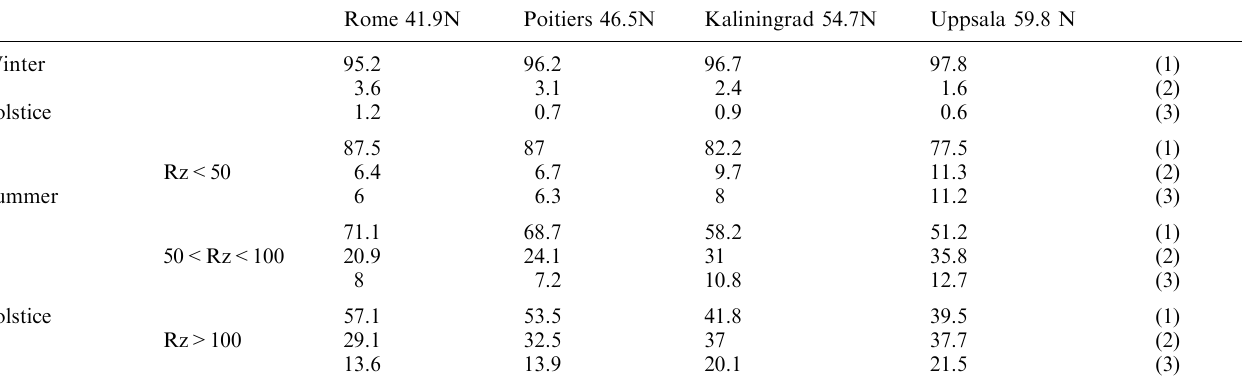
Table 2. Relative contributions of the main sources for f oF2 variability in relation to solar activity, season and latitude. Row (1) is for contributions of daily variations, (2) for contributions linked with the planetary wave activity (all periodic bands from 2.5- to 9-day), and (3) for contributions associated with solar flux variations (14- and